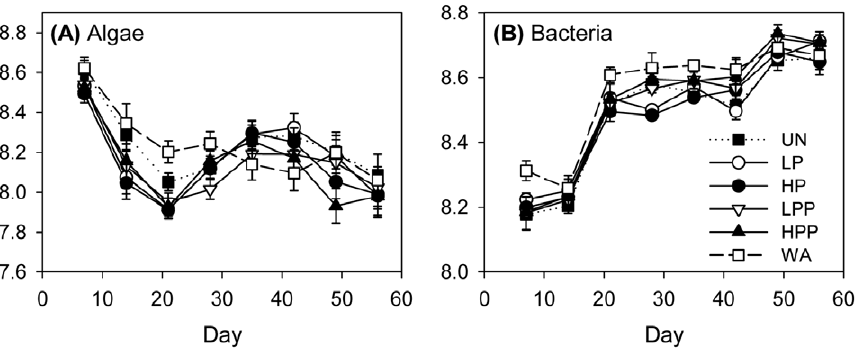
Figure 5. Algal biovolume (A) and total bacterial biovolume (B) in the metacommunities. Treatment abbreviations and symbols as in Fig. 2. Additionally, resources were measured in isolated basins without animals (WA), shown with dashed line and open squares. Values are means 6 SE (n=2 for WA, n=3 for all other treatments).